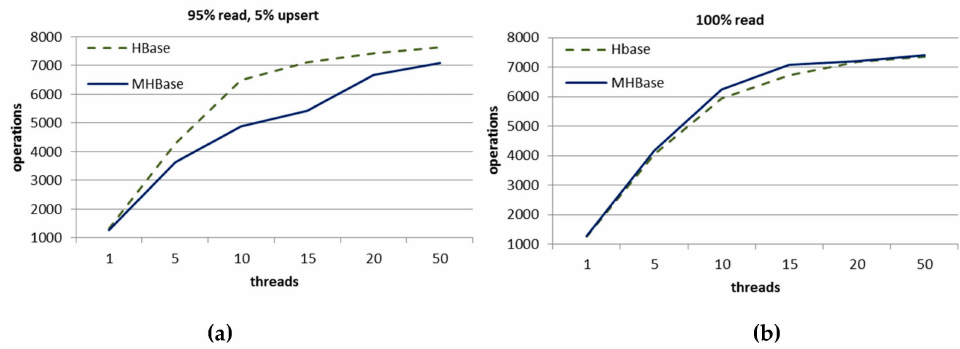
Figure 10. Performance in different circumstance: (a) 100% read operations; and (b) 95% read and 5% upsert